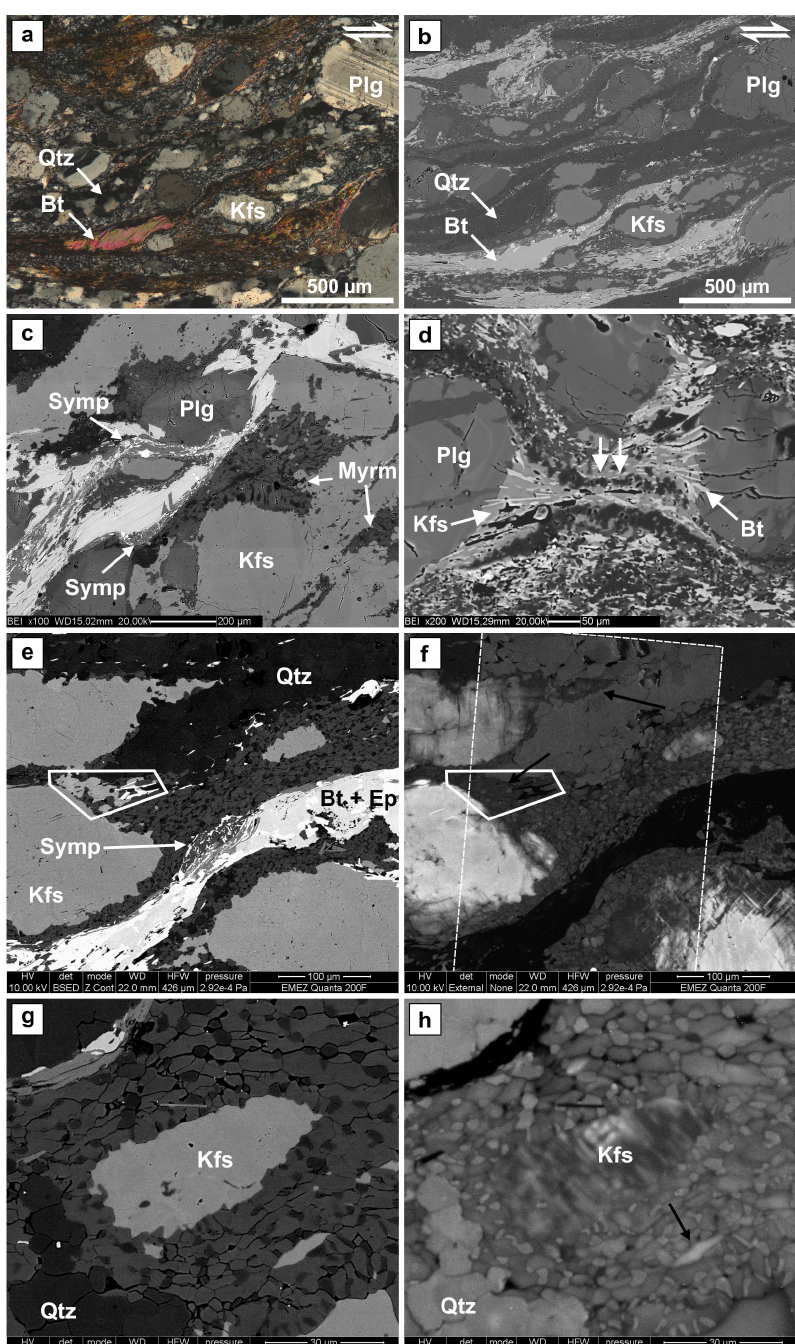
Figure 1. Microstructures of Rieserferner granodiorite mylonites. (a) Micrograph (crossed polarizers) showing the alternating layers of recrystallized Qtz, recrystallized Bt + Plg + Qtz, and Plg + Qtz. White arrows indicate layers of recrystallized Qtz (upper) and Bt (lower). (b) SEM-BSE image of the area shown in (a) . (c) SEM-BSE image of a pristine myrmekite (Myrm) replacing Kfs. Plg + Ttn symplectites (Symp) are indicated by white arrows. (d) SEM-BSE image of the Kfs + Bt tails in strain shadows between two Plg porphyroclasts. Kfs in the strain shadows is in turn replaced by myrmekite (white arrows). (e) SEM-BSE image of a Kfs porphyroclast and of sheared myrmekite. Pristine myrmekite developed on Kfs boundaries parallel to the mylonitic foliation are sheared to form Plg + Qtz aggregates (sheared myrmekite). The white polygon encloses Kfs neoblasts in strain shadows and sheared myrmekite. Plg + Ttn symplectites (Symp) are indicated by white arrows. (f) CL image of (e) . Black arrows indicate the Kfs in strain shadows and porphyroclast tails showing dark- grey homogeneous CL shades. Note the alteration of the CL signal in Qtz after the EBSD scan (area delimited by white dashed line). (g) Kfs and sheared myrmekite aggregate (particular of the EBSD map of Fig. 3). (h) CL image of (g)